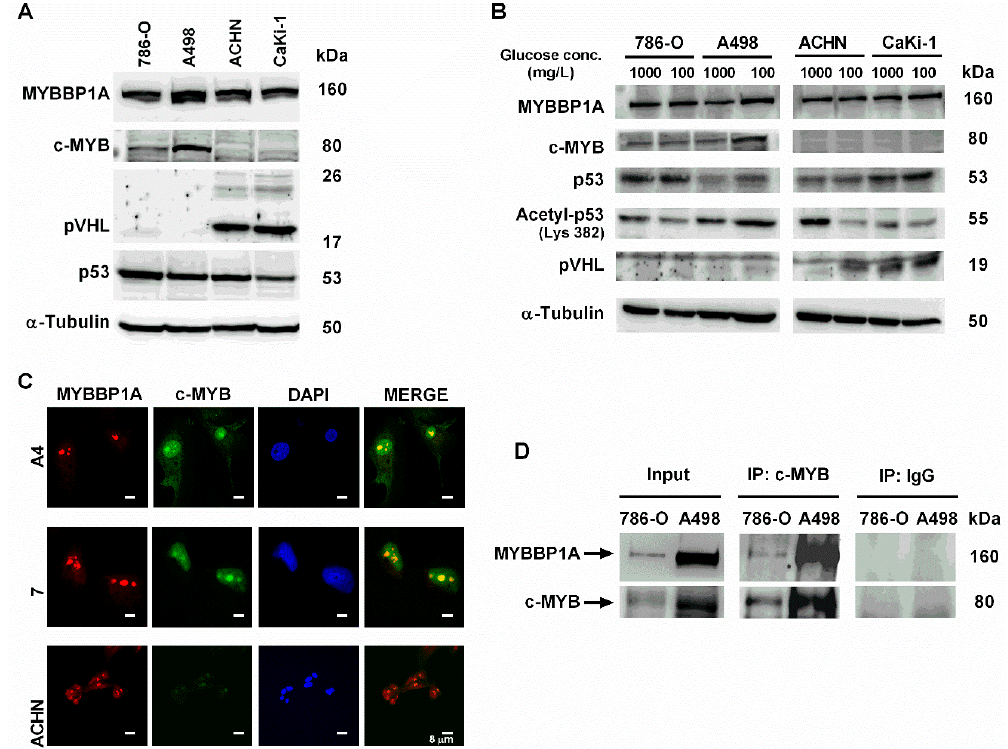
Figure 1. Characterization of MYBBP1A expression and MYBBP1A binding to c-MYB in renal carcinoma cell lines. ( A ) Measurement of MYBBP1A, c-MYB, p53 and pVHL levels in renal carcinoma cell lines A498, 786-O, ACHN and CaKi-1 by western blot. Cells were cultured in 4500 mg/L glucose